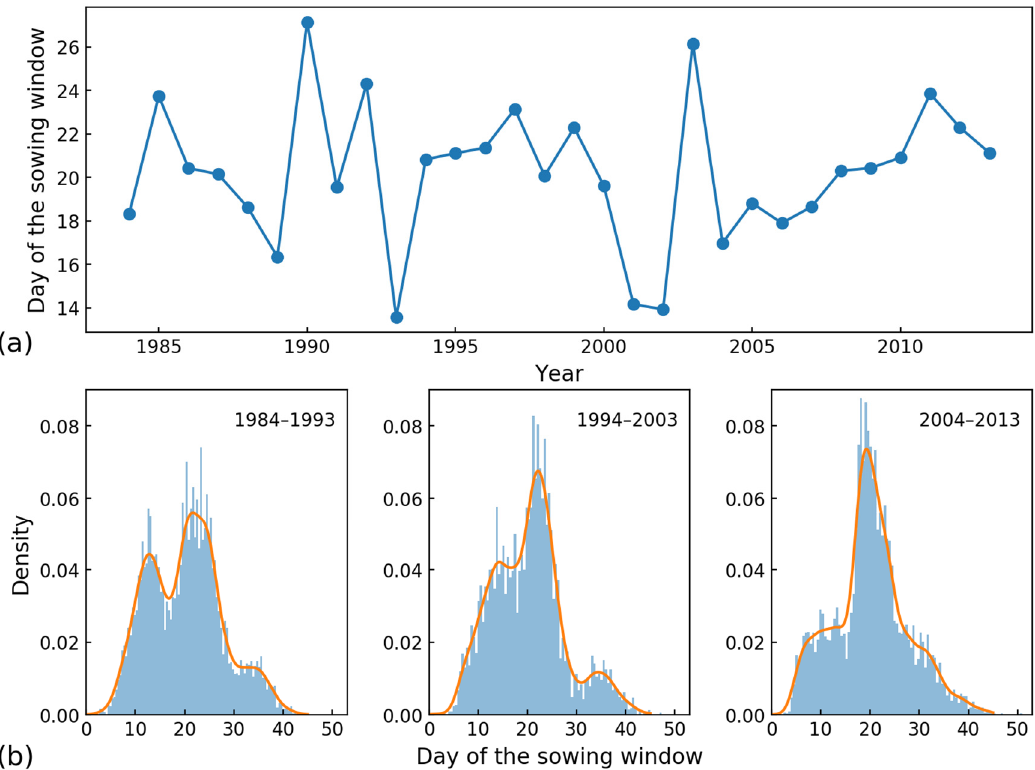
Figure 2. Changes in sowing date of maize related to rainfall onset: ( a ) National mean of the sowing date represented by the starting day of sowing within the planting window; ( b ) Distribution of sowing dates for areas under maize cultivation over three decades. Sowing date over the country is represented as the day from the start of planting window due to large spatial variation of the planting calendar. Gridded sowing window information is obtained from ref [26] and is based on data for 2006.